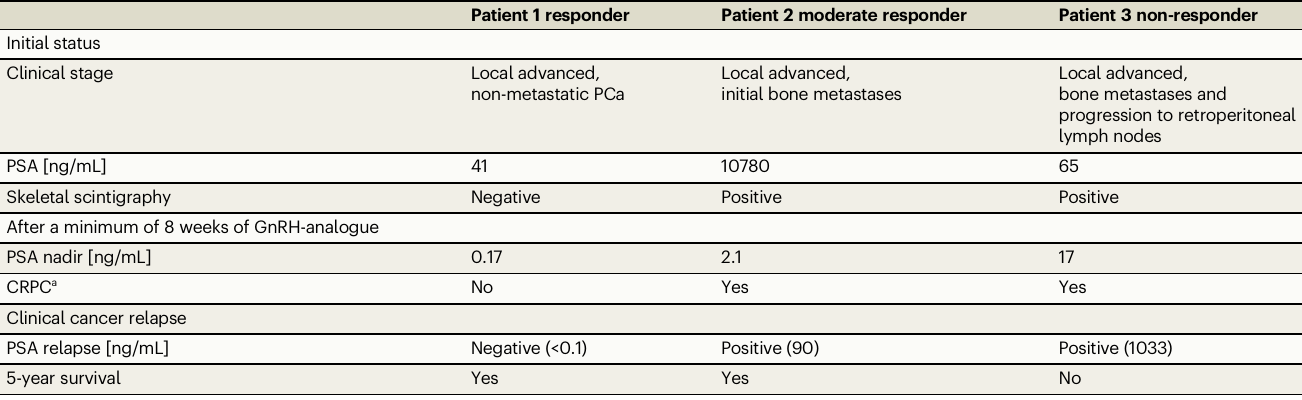
Table 1 | Clinical data for the three patients used in the study